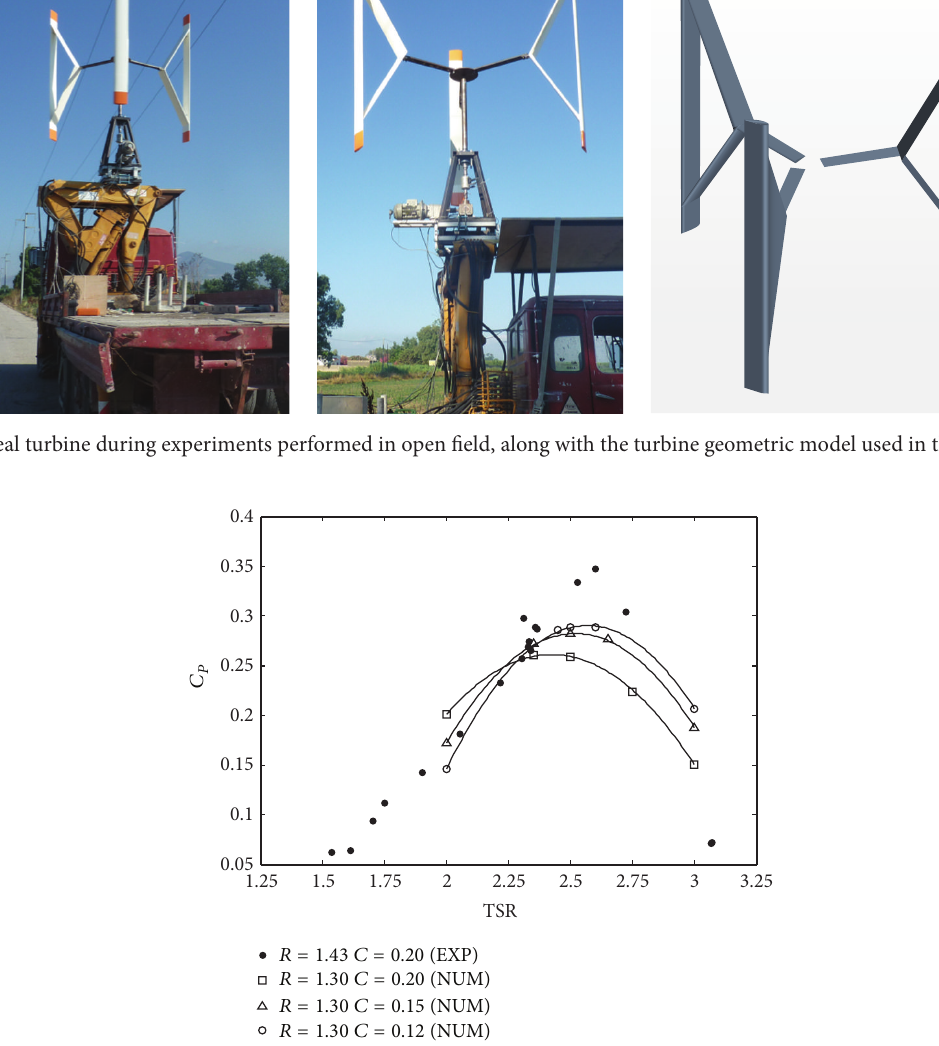
Figure8:Turbineperformancecoefficientsasaresultofexperimental(EXP)andnumerical(NUM)data.Numericalanalyseswereperformed on several geometries (radius 𝑅 and inclined arm chord 𝐶 in